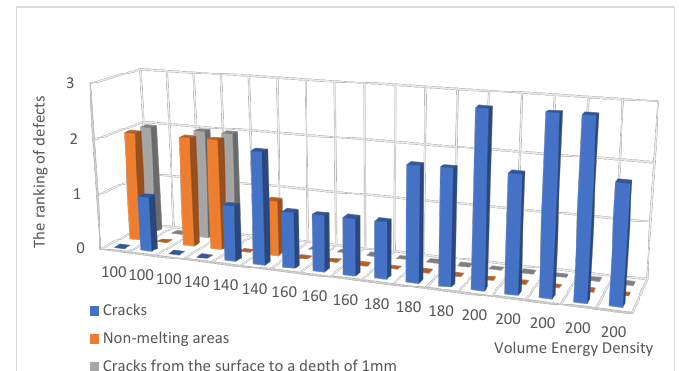
Figure 3. The histogram of defects from Table 2.